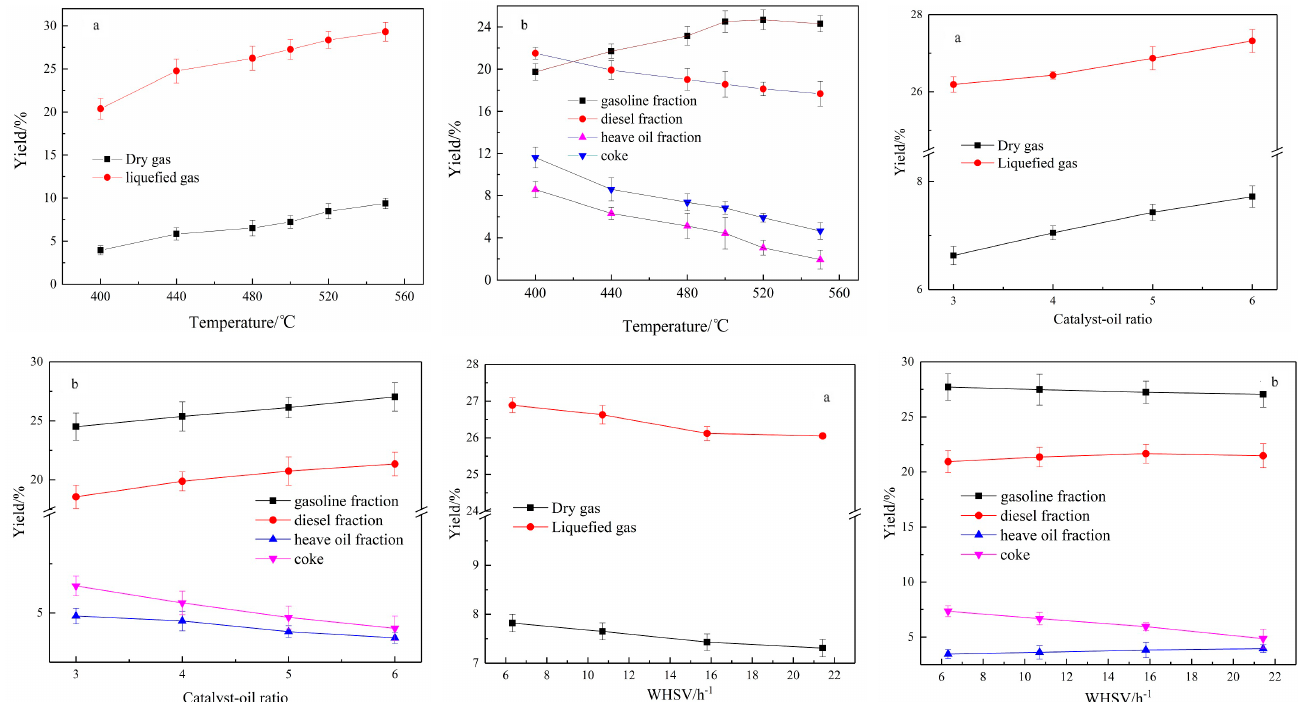
Figure 2. Product yield of FCC waste cooking oil in different process conditions. ( a ) Pyrolysis gases; ( b ) liquid products and coke.